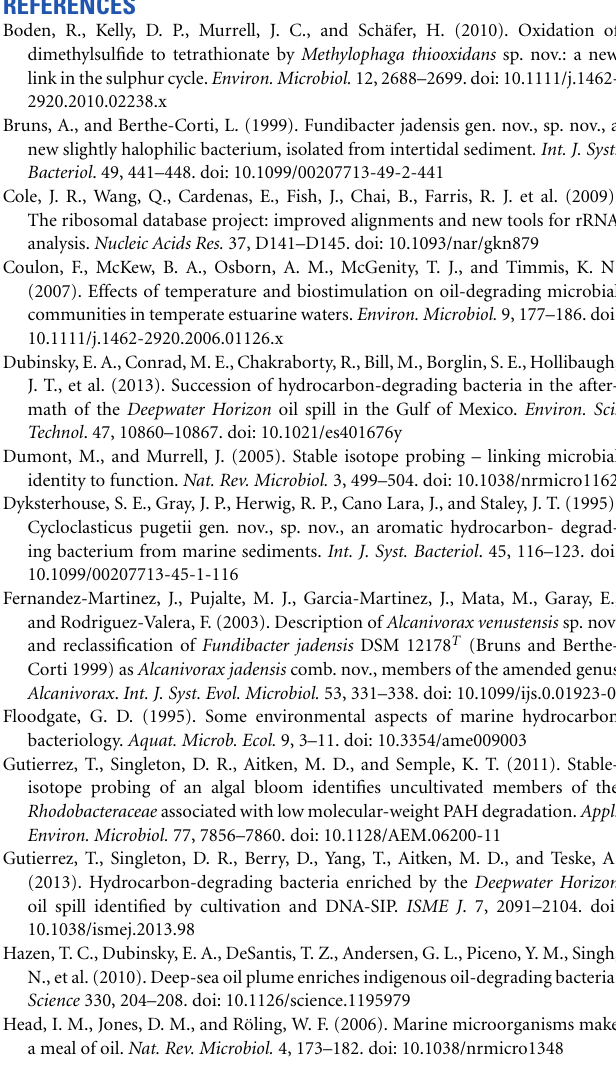
Supplementary Table 1 | Singleton 16S rRNA gene sequences recovered from the heavy DNA clone library a